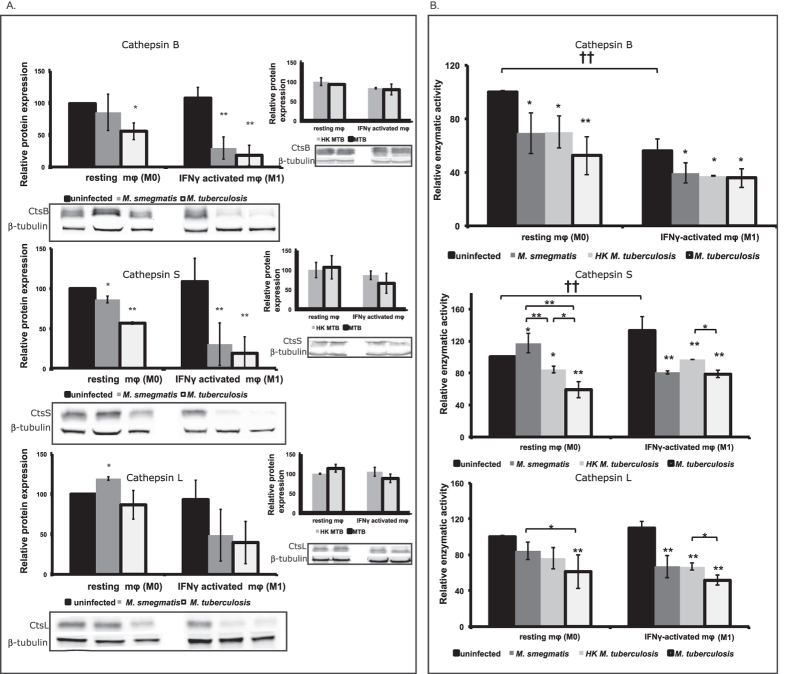
Protein expression and enzymatic activity of cathepsin B, S and L in M0 or M1 macrophages infected with MTB, HK MTB or M. smegmatis for 24 h.(A) Protein expression: Bar plots represent protein expression relative to uninfected control and were obtained by densitometry analysis of the western blots relative to the β-tubulin control. (B) Cathepsin activity was measured with a fluorimetric substrate that is activated by cleavage of a cathepsin-specific sequence. Values are depicted relative to uninfected control, and the statistical comparisons were performed within M0 or M1 groups relative to their respective uninfected control (*p < 0.05 and **p < 0.01; n = 4) or between groups (†p < 0.05 and ††p < 0.01; n = 4) unless otherwise indicated in the plot.